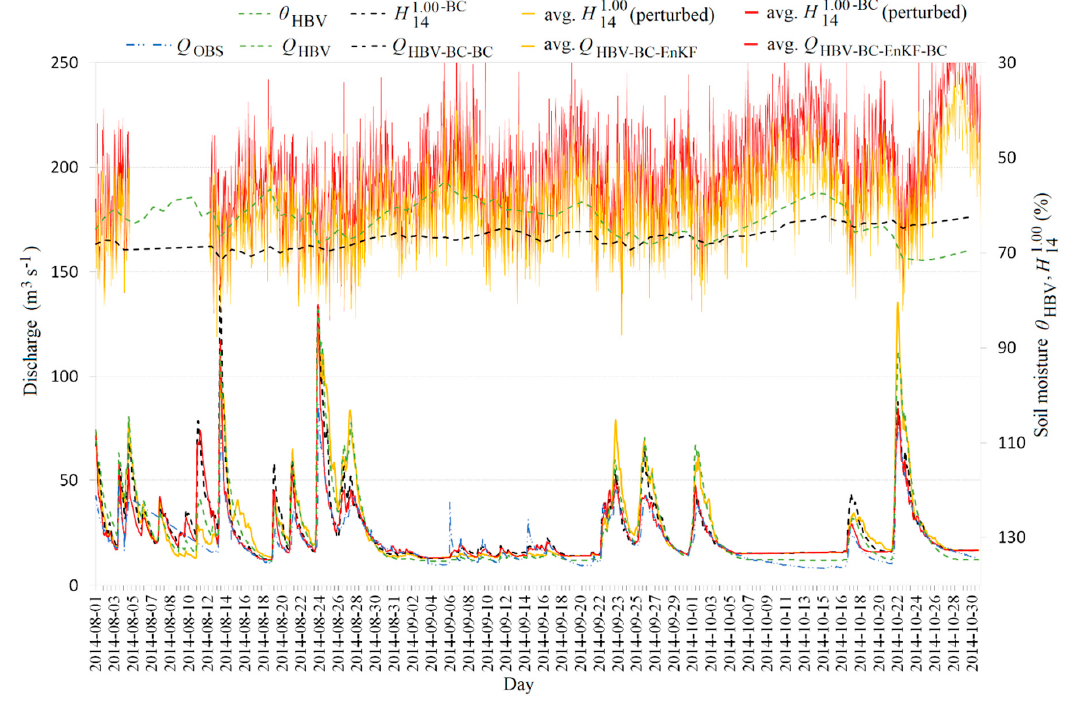
Figure 6. The comparison of Q OBS (observed flow; dashed blue line with double dots), Q HBV (HBV product for P OBS ; dashed green line), Q HBV − BC − BC (HBV product for P BC and for H 1.00 − BC without assimilation; dashed black line), avg. Q HBV − BC − EnKF (averaged HBV product for P BC with assimilation the H 1.00 using the EnKF filter; solid orange line), avg. Q HBV − BC − EnKF − BC (averaged HBV product for P BC with assimilation the H 1.00 using EnKF-BC filter; solid red line), θ HBV (HBV soil moisture product, dashed green line), H 1.00 − BC (corrected satellite soil moisture product; dashed black line), avg. H 1.00 (perturbed) (averaged ensemble of perturbed H 1.00 without BC method; solid orange line) with avg. H 1.00 − BC (perturbed) (averaged ensemble of perturbed H 1.00 with BC method; solid red line) in the Sola Basin at Zywiec in the summer period from 06:00H, 1 August 2014 to 23:00H, 31 October